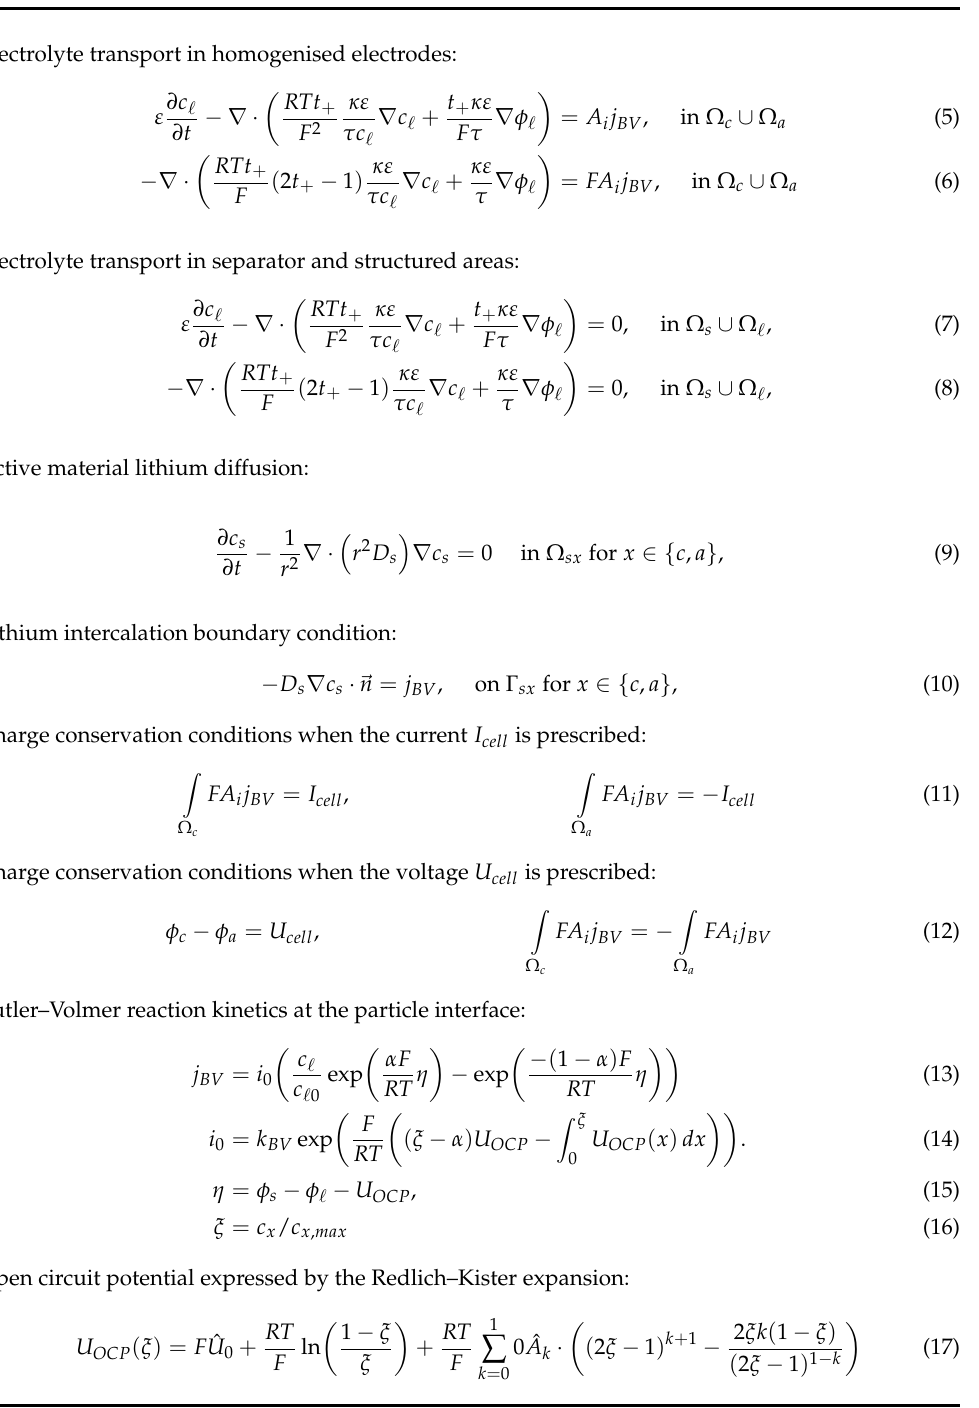
Table 1. Summary of model